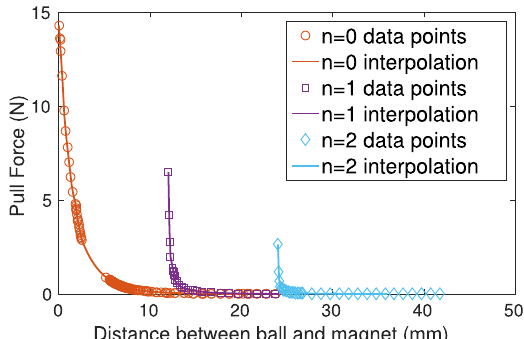
Fig. 4. Pull forces F 0 , F 1 , and F 2 for bigballs, as a function of distance d between themagnet and the border of the ball. Note that d is de fi nedfrom the magnet itself, which is why F n is de fi ned only for d ≥ n ⋅ 12 mm. E n was obtained by integrating the cubic interpolant